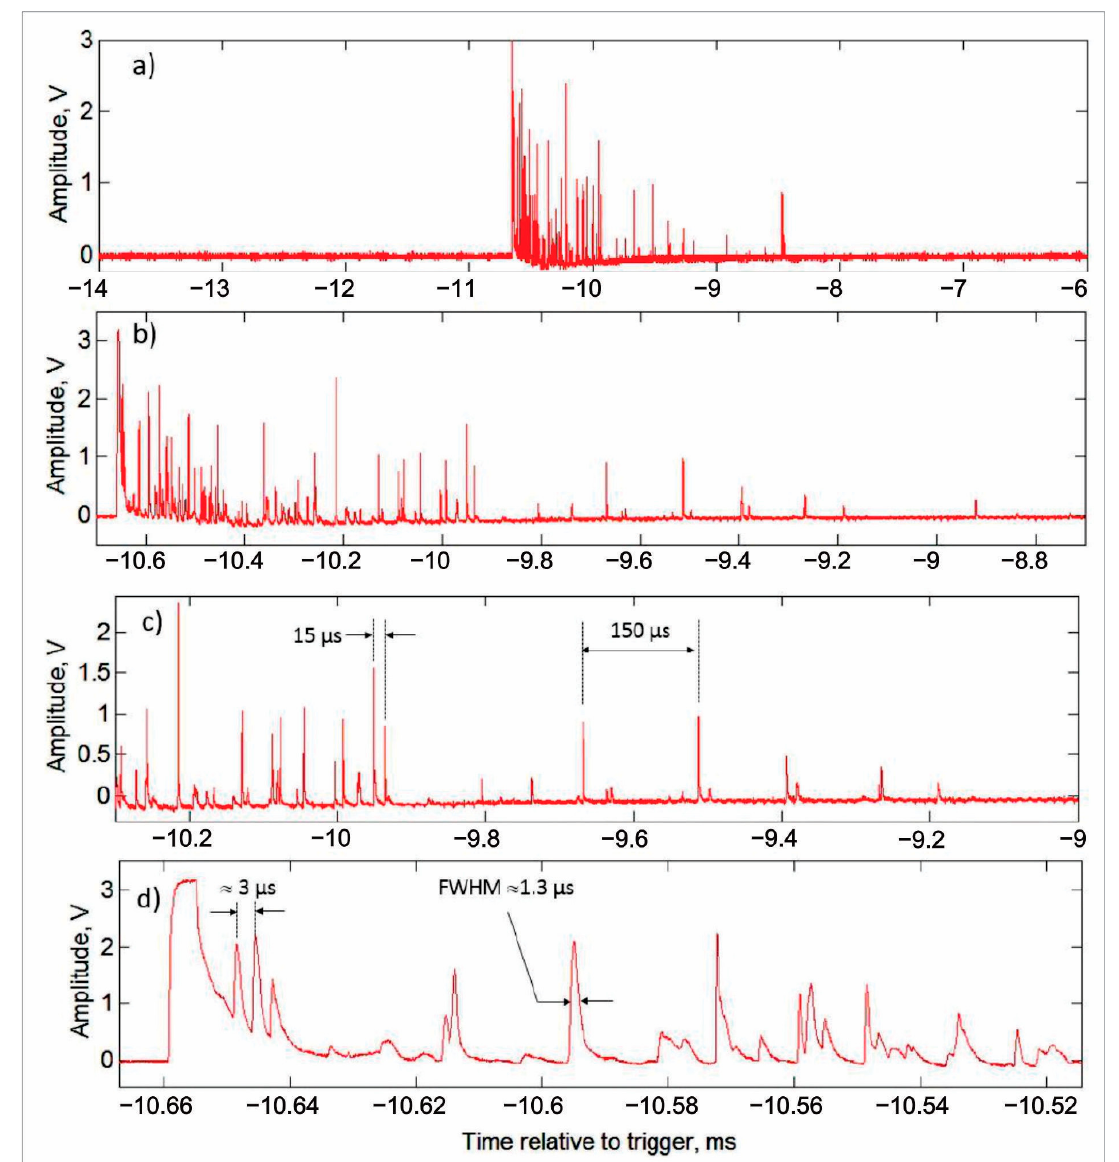
Figure 15. Oscillograms of the neutron burst that occurred at 04:08:05 on 26 November 2016. Flash duration of 2.2 ms and multiplicity of 107. Four panels ( a – d) show burst records on different time scales. ©New Astronomy. Reproduced with permission.